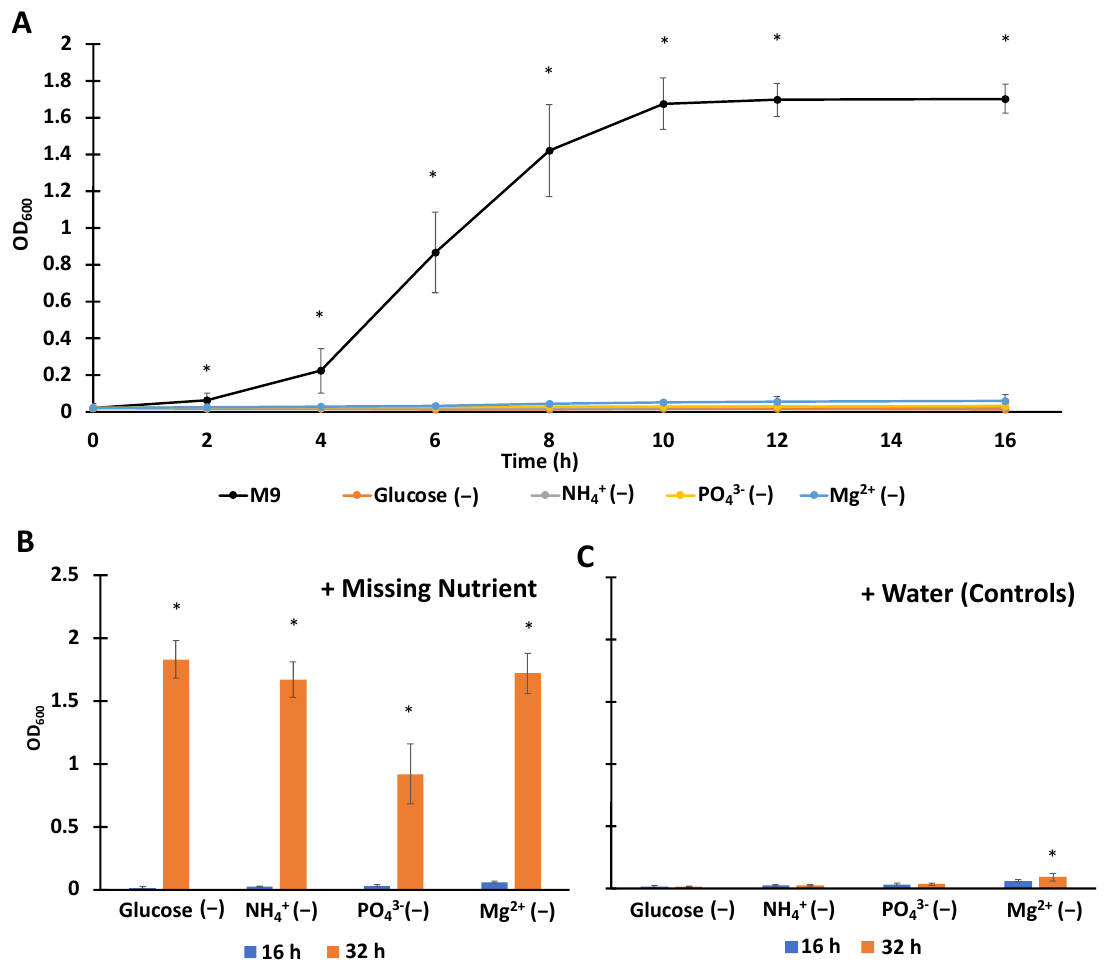
Figure 1. Establishment of culturing conditions for overnight starvation to individual nutrients. ( A ) Exponentially-growing wild-type (WT) cultures were inoculated into complete media or media deprived of carbon (C), nitrogen (N), phosphate (P), or magnesium (Mg 2+ ) at an optical density at 600 nm (OD 600 ) of 0.02. After inoculation, OD 600 was measured at indicated time points, and all cultures in the nutrient-starved conditions exhibited growth inhibition. ( B ) After 16 h in nutrient-starved environments (0 – 16 h), the missing nutrients were supplied to cultures and incubated for an additional 16 h (16–32 h). Addition of the missing nutrient resulted in growth of all cultures, demonstrating single-nutrient limited growth. ( C ) Controls where autoclaved water was added in place of the missing nutrient and growth was monitored for an additional 16 h (16–32 h). Data points indicate the means of three biological replicates, and the error bars indicate the standard errors of the means. A schematic of the culturing procedure with respect to different assays is provided in Supplementary Figure S1. ( A ) One-way ANOVA with post-hoc Tukey tests were conducted to assess significance among the different treatment conditions. * Indicates significance with p < 0.05 with respect to the other treatment conditions at the same time point. ( B , C ) t -tests were conducted for significance analysis. * Indicates significance with p < 0.05 with respect to t = 0 h for the same treatment